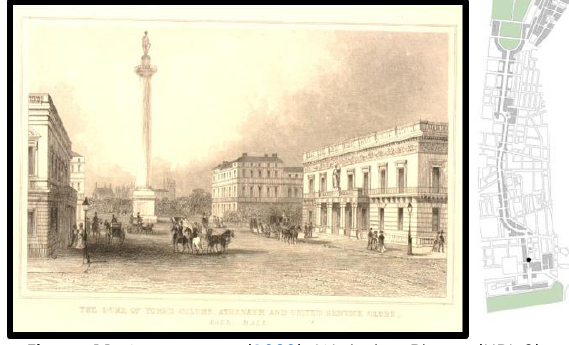
Figure 11: Anonymous (1828). Waterloo Place . (URL 8) Sir John Summerson points out that three concepts of revivals characterise the 18th and 19th century periods (Summerson 1958, p. 92